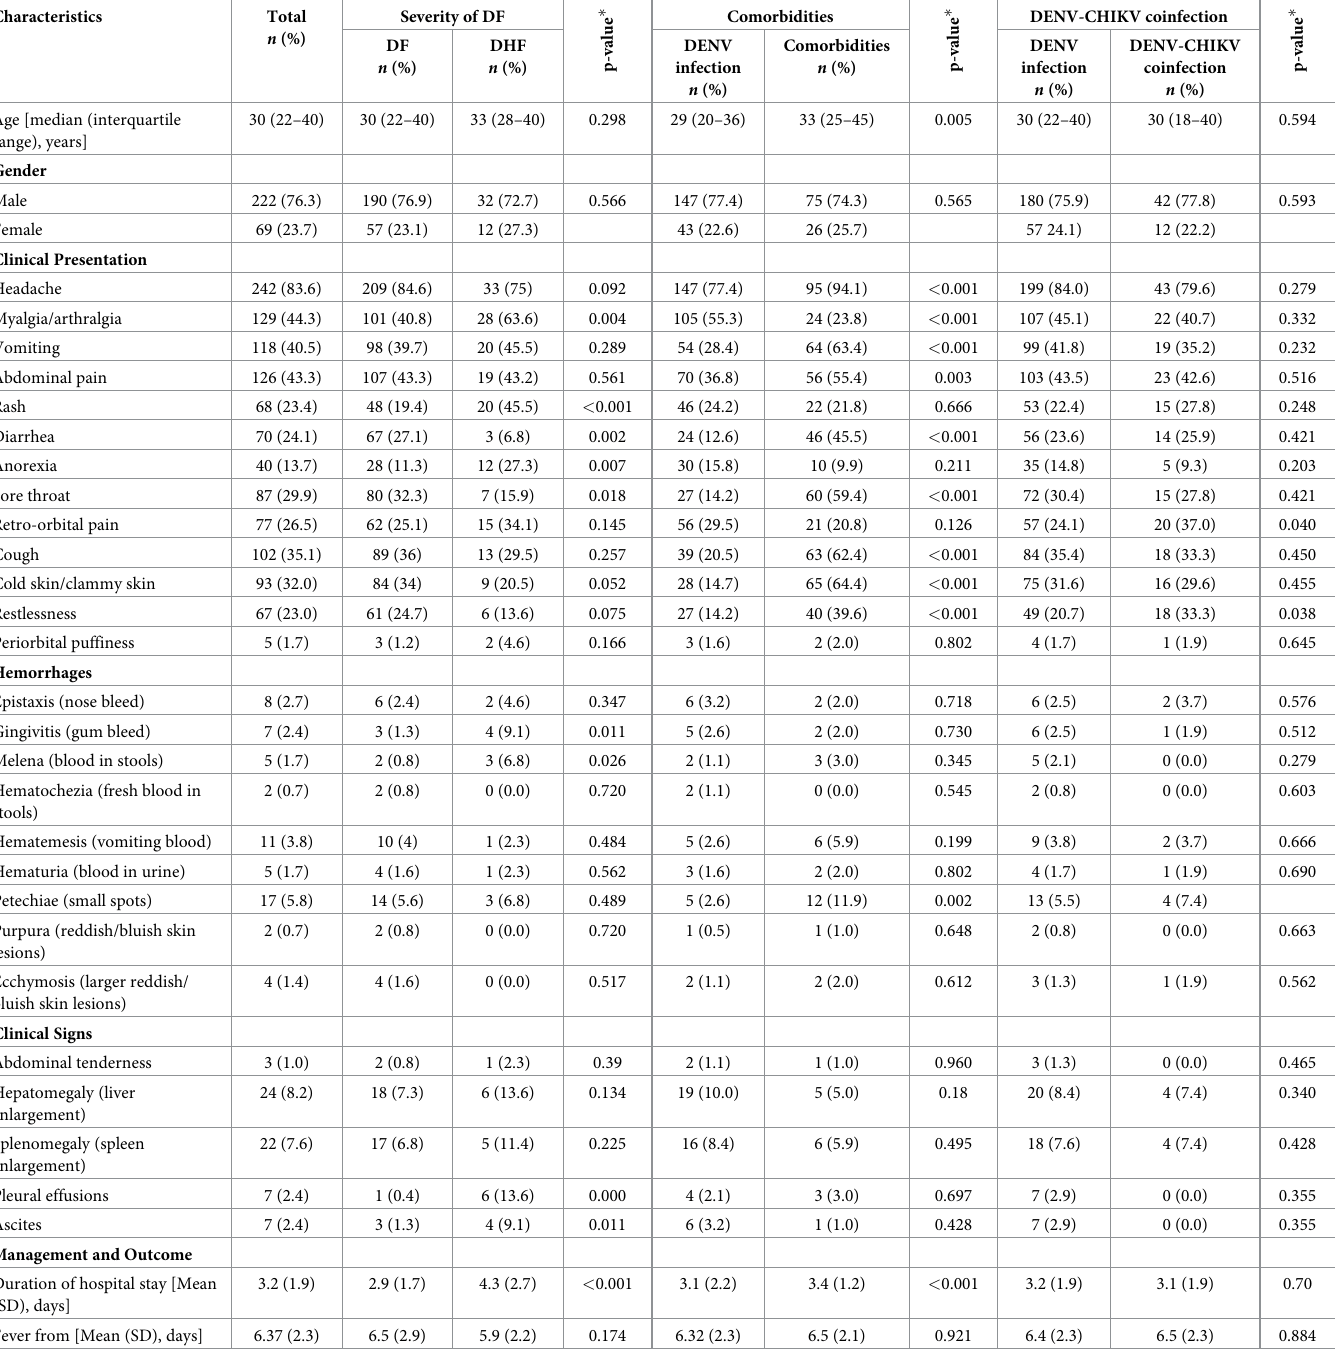
Table 2. Clinico-epidemiological features of hospitalized patients reported with DENV infection alone or with comorbidities or with DENV-CHIKV co-infection in Lahore and Rawalpindi cities.